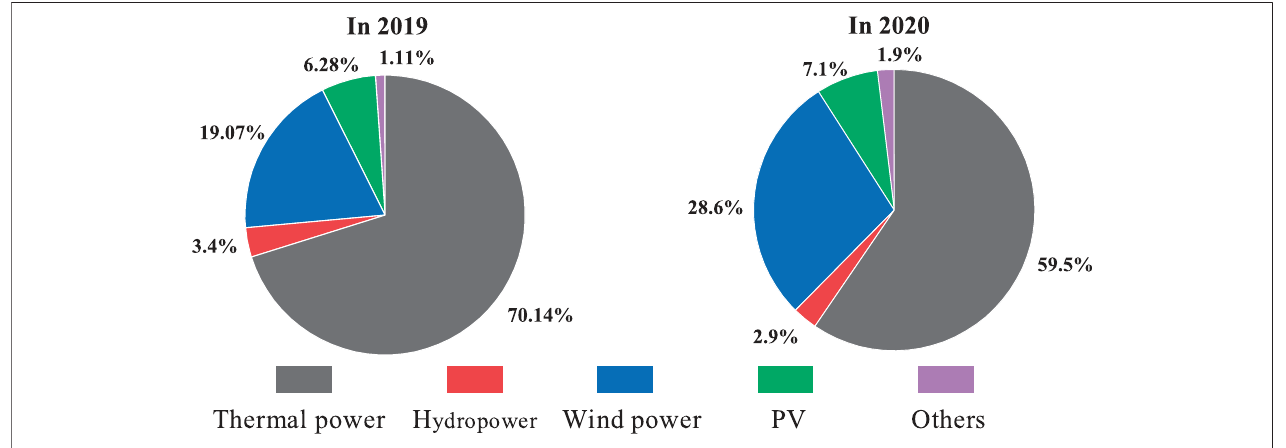
FIGURE 1 | Illustration for the installed power generation in the Heilongjiang power grid .